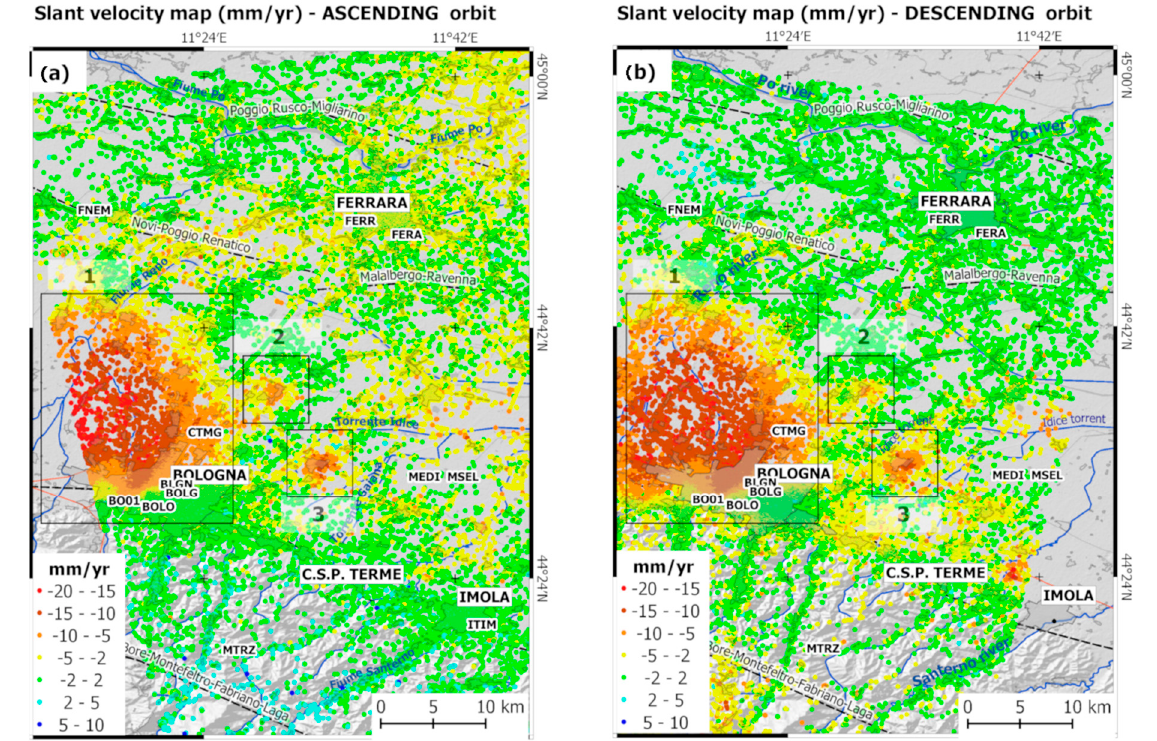
Figure 4. Line-of-site (LOS)-oriented and geocoded velocity maps (mm/yr) obtained from the ascending ( a ) and descending ( b ) orbits within the study area. In the legend, red correspond to a range increase (movement away from the satellite). Areas enclosed by rectangles identify zones characterized by significant deformation phenomena: (1) Bologna metropolitan area; (2) municipality of Minerbio; and (3) municipality of Budrio. The four alphanumeric characters code of the CGNSS sites indicate the locations of the sites within the study area. BOLG represents the reference CGNSS site adopted for the calibration for the LOS-oriented velocities to the European Terrestrial Reference Frame, ETRF14.